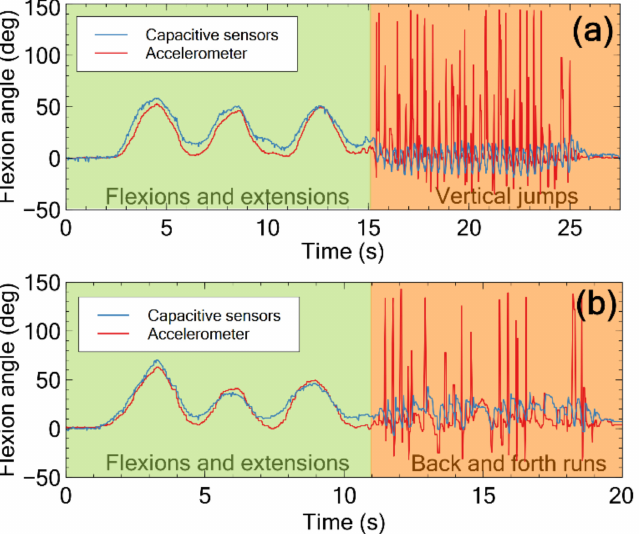
Figure 7. Example of a pair of signals simultaneously detected by the capacitive sensors and the accelerometer during a movement consisting of three low-frequency flexion-extension cycles, followed by a sequence of: ( a ) vertical jumps in place; ( b ) back and forth runs. The peaks detected by the accelerometer lead to an evident angular